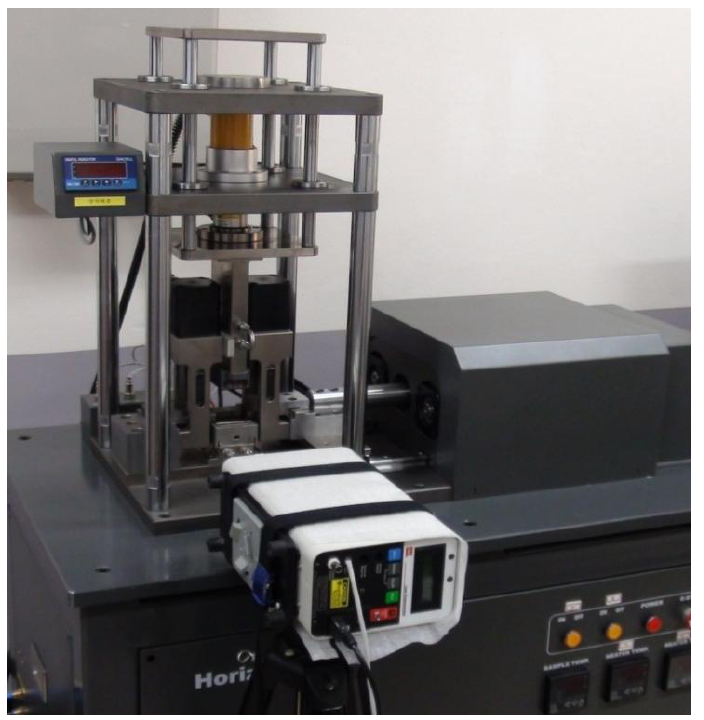
Figure 2. The tension-compression tester of horizontal loading type with upper and lower heating system, anti-buckling system, and laser extensometer to measure axial